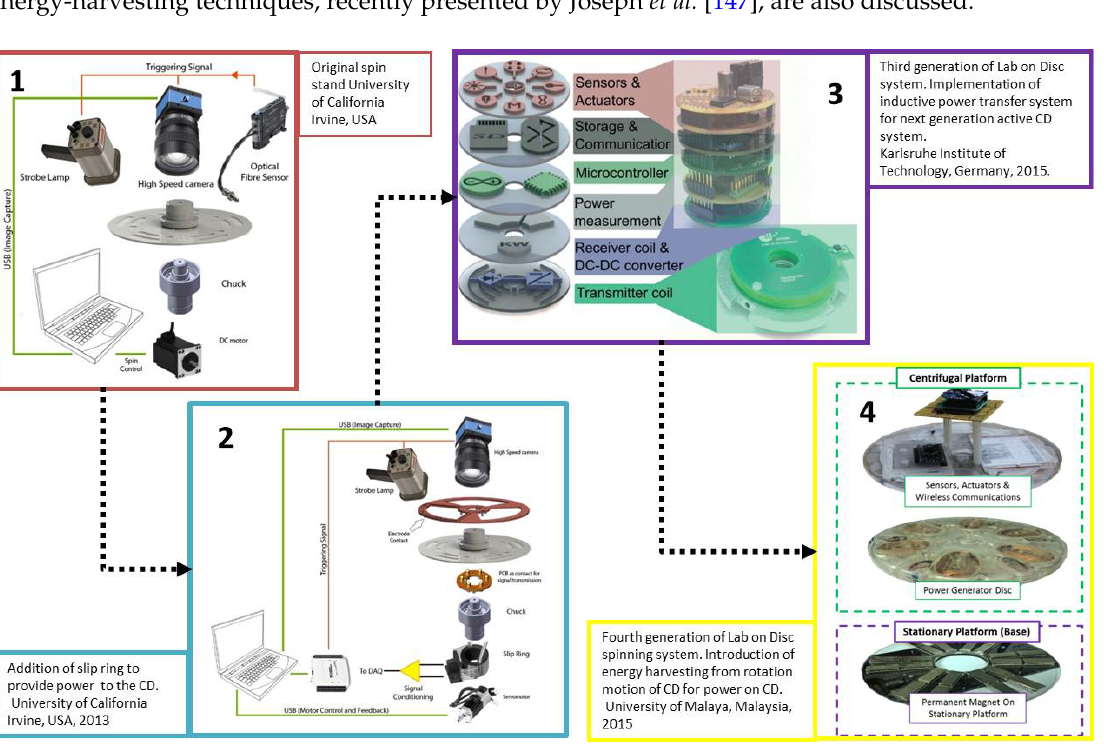
Figure 12. Progression of centrifugal microfluidic technology platforms towards stand-alone POC systems from different research groups. System 1 shows the original spin stand structure [38]. System 2 illustrates the addition of a slip ring to the spin stand set-up [140]. System 3 shows the implementation of an inductive power transfer system, reproduced in part from [58] with permission of the Royal Society of Chemistry. System 4 illustrates energy harvesting through the rotating motion of the disc